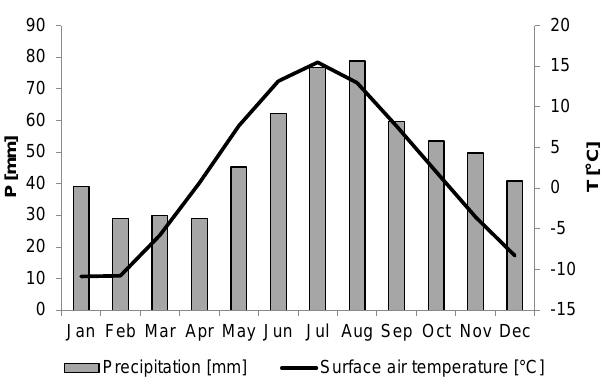
Figure 2. The long-term (1959–2013) monthly mean values of sur- face air temperature and the amount of precipitation recorded at the station located 10km south-west of the study site (Finnish Meteo- rological Institute,